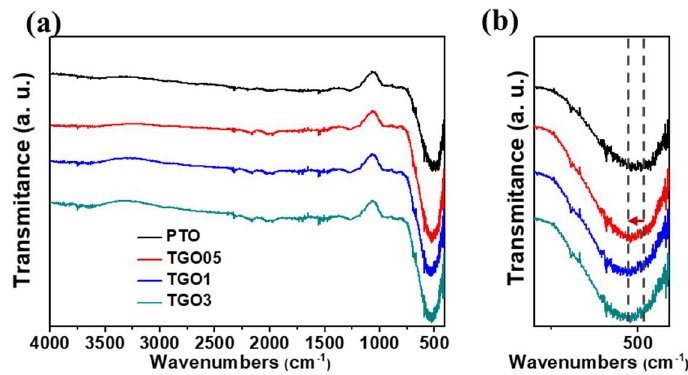
Figure 2. ( a ) Fourier transform infrared spectra and ( b ) their magnification in the low-wavenumber region for the pristine SnO 2 aerogel (PTO) and the SnO 2 aerogel/reduced graphene oxide (rGO) nanocomposites with different rGO loadings (0.05 wt.%: TGO05; 0.1 wt.%: TGO1; 0.3 wt.%: TGO3).